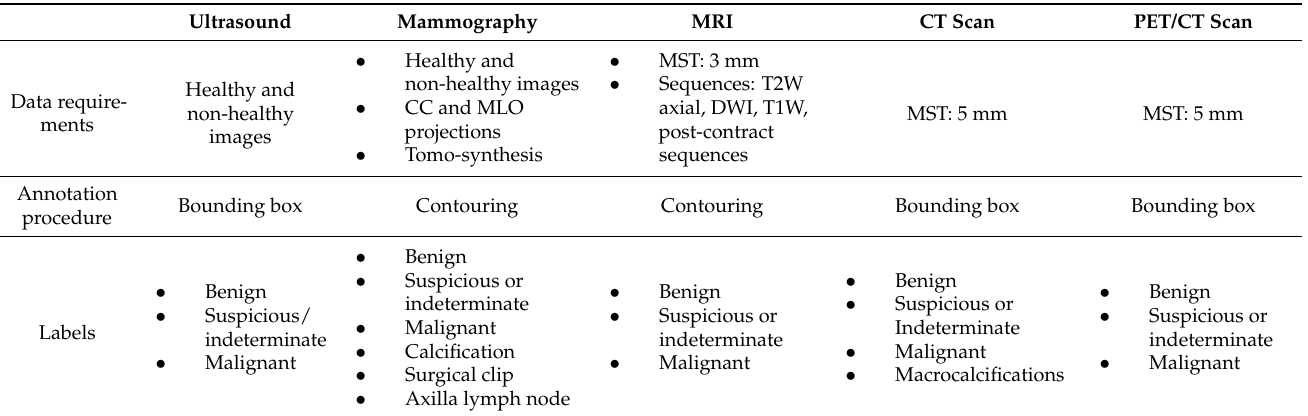
Table 1. The modality annotation convention in the INCISIVE